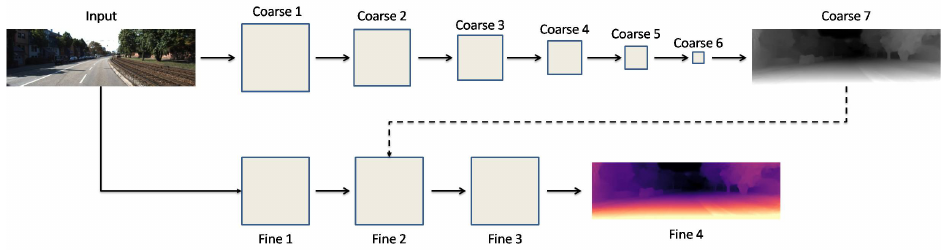
Figure 10. Developed network structure by Eigen et al. [9].